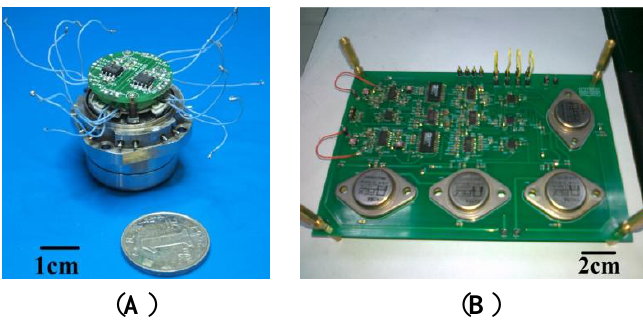
Figure 14. HG Prototype. ( A ) HG structure. ( B ) PCB circuit.